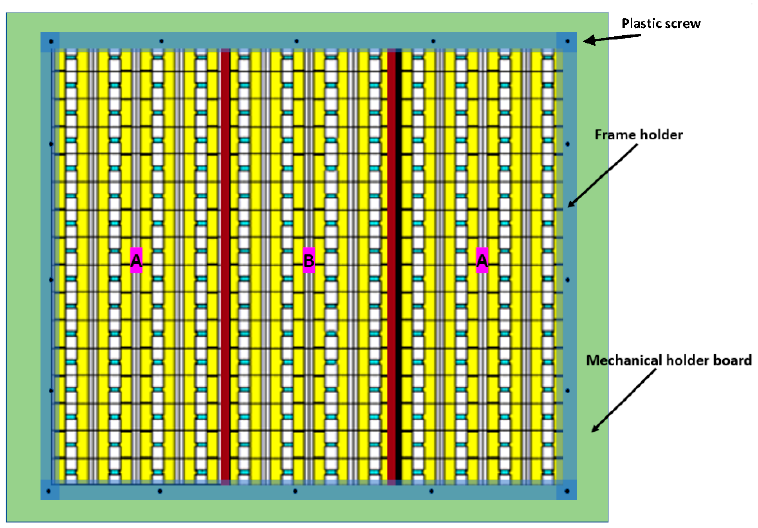
Figure 13. Full and detailed realization of the three-stripe MS.